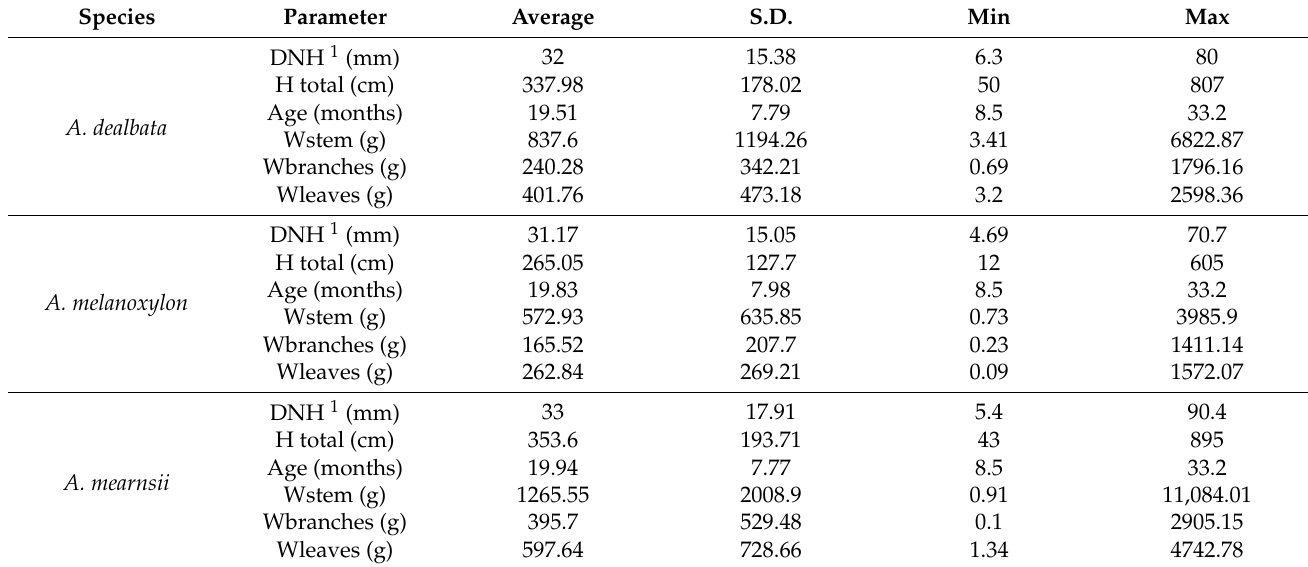
Table 1. Descriptive statistics obtained for the predictor variables and the dry biomass for the tree components of Acacia dealbata , Acacia melanoxylon and Acacia mearnsii .